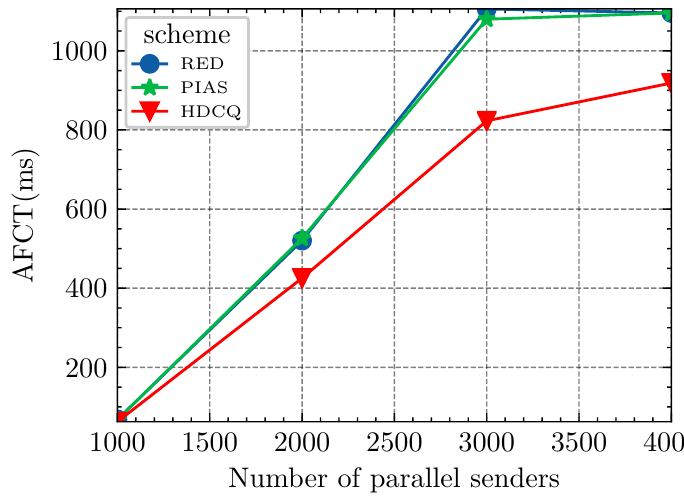
Figure 9. Incast environment, the impact of different scheme on short-flow AFCT.